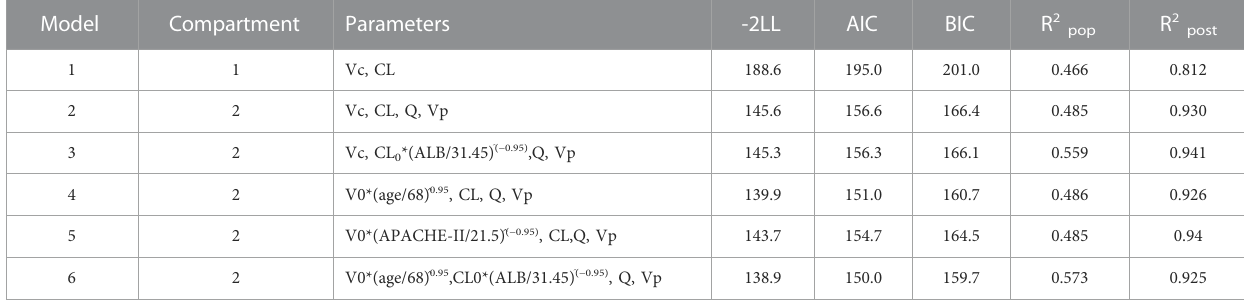
TABLE 2 C hanges in fi tted values brought on by the construction of base model and stepwise covariate models a .